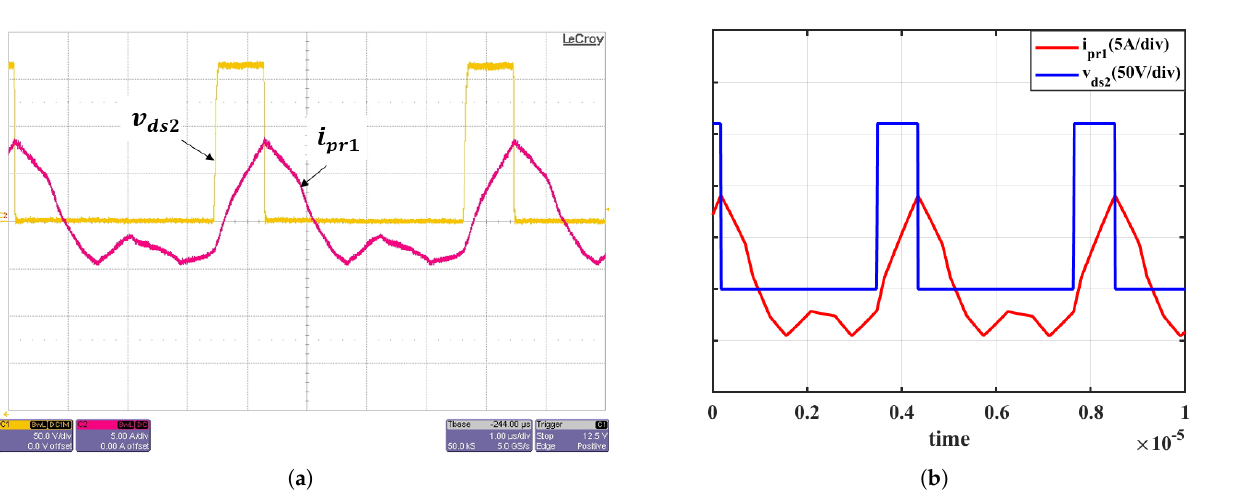
Figure 18. Waveforms at 160 V input and 35% load condition ( a ) Experimental Voltage across switch S 2 ( v ds 2 (50 V/div)) and primary current i pr 1 (5 A/div) ( b ) Simulated voltage ( v ds 2 (50 V/div)) and current i pr 1 (5 A/div) from PSIM.